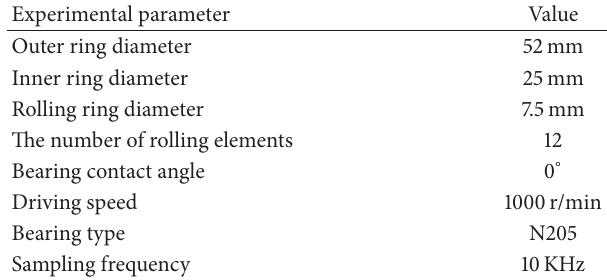
Table 2: The characteristic parameters in frequency domain. Number